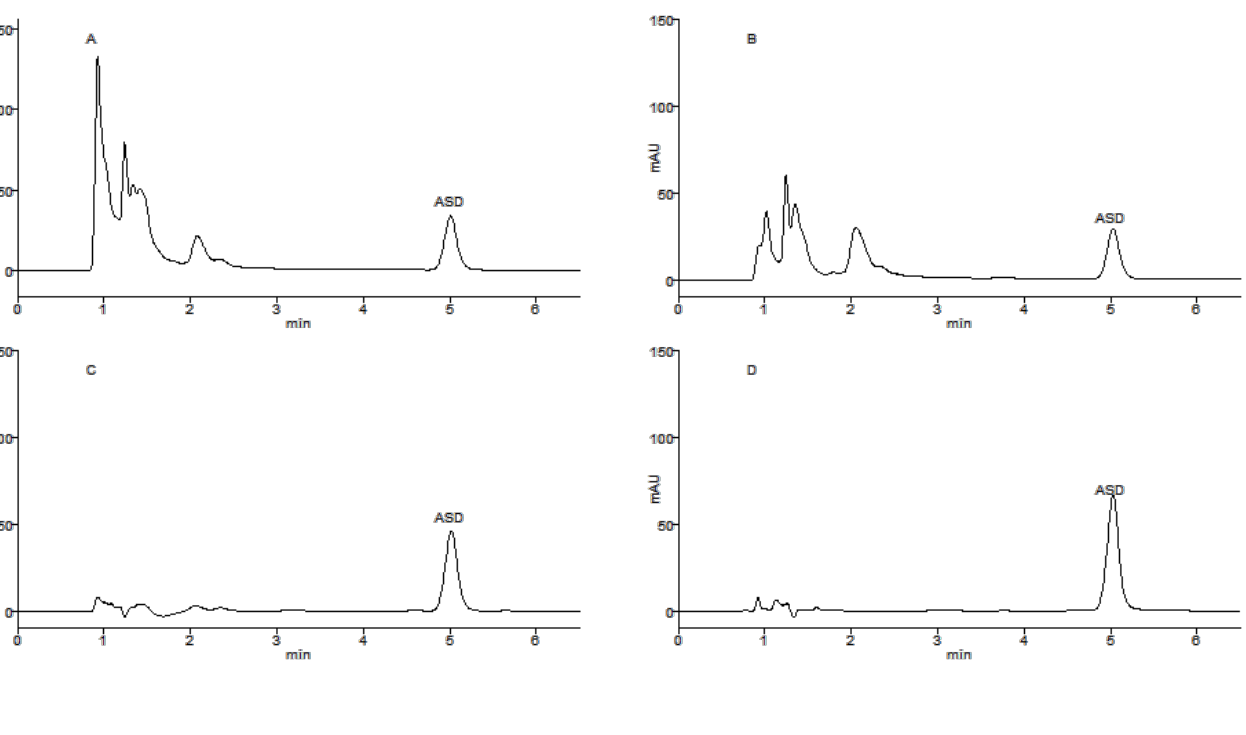
Figure 5. HPLC chromatograms of the loading solution of HPD-722 ( A ), the loading solution of ADS-7 ( B ), the purified ASD ( C ), and ASD standard ( D